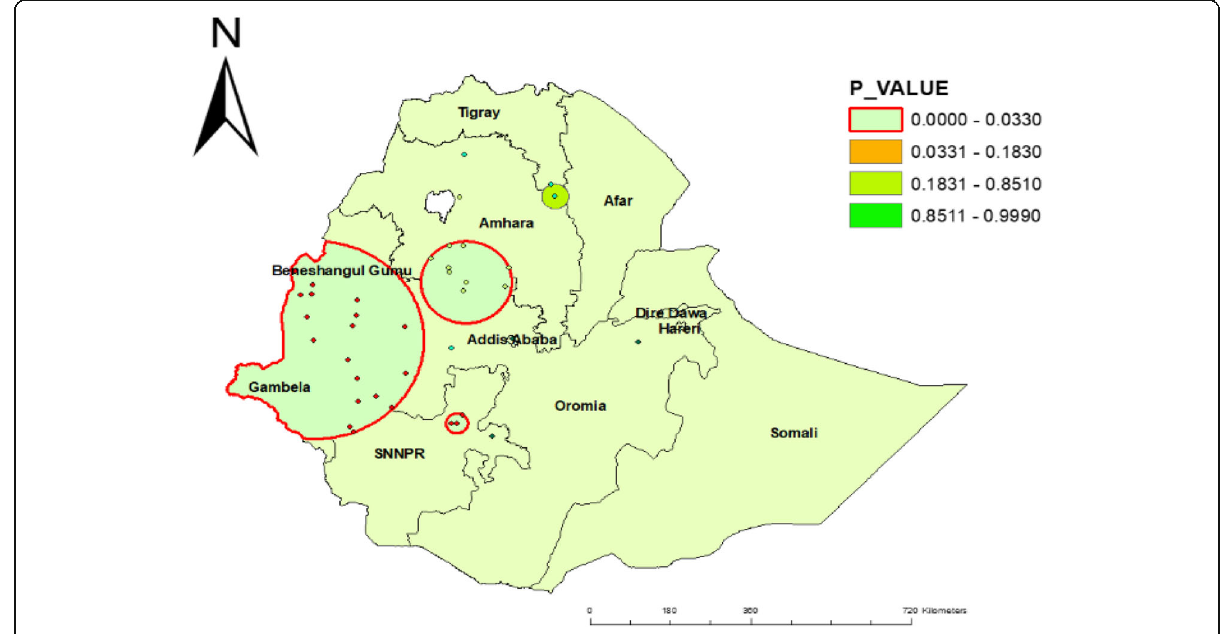
Fig. 5 SaTScan results of childhood diarrheal disease among under-five children in Ethiopia, EDHS